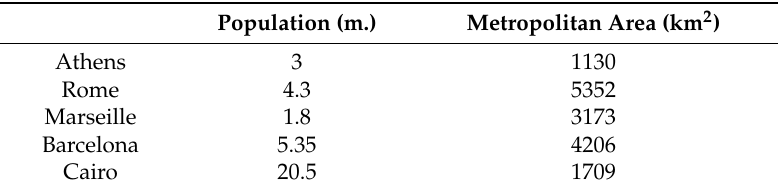
Figure 1. The Mediterranean Sea and the location of the five selected cities. Table 1. Selected cities and their